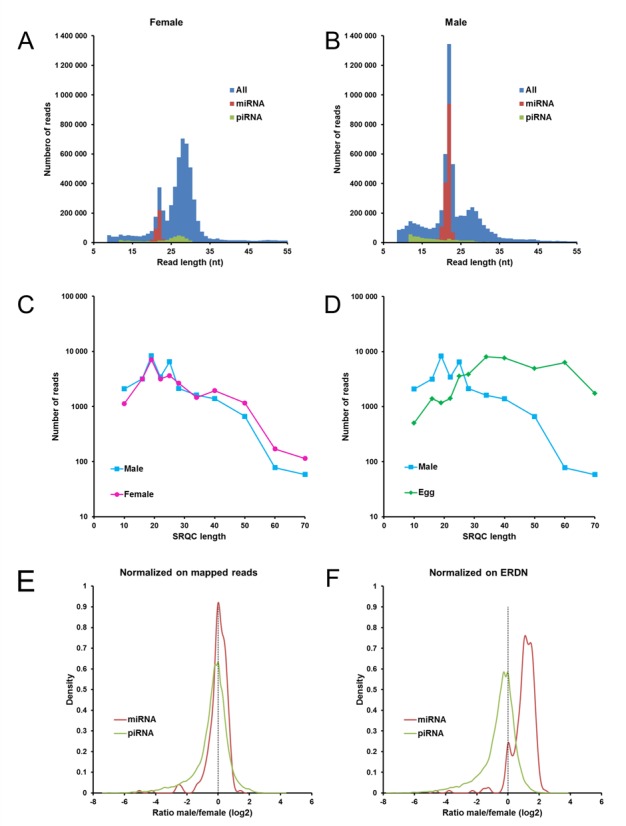
Using ERDN for normalization of samples with different miRNA content. (A and B) Size distribution of sRNA in female and male adult zebrafish. Histograms of the number of reads versus the read length are shown for a female (A) and a male (B) adult zebrafish. Blue, all reads; red, miRNA-mapped reads and green, piRNA-mapped reads. Reads shorter than nine nucleotides are not included. (C and D) Size-selection profile in zebrafish samples. Comparison of the SRQC reads between the female and male adult zebrafish (C) and between male and egg (D). (E and F) ERDN-based normalization preserves the natural miRNA content. Reads were normalized by DESeq using as a reference either the number of mapped reads (E) or the ERDN spike-in set (F). For each miRNA and piRNA, the average number of reads was calculated over four female and over four male zebrafish. The log2 ratio of male over female miRNAs (red) and piRNAs (green) is displayed in kernel density plots. The vertical dashed line indicates an equal number of reads in female and male zebrafish.